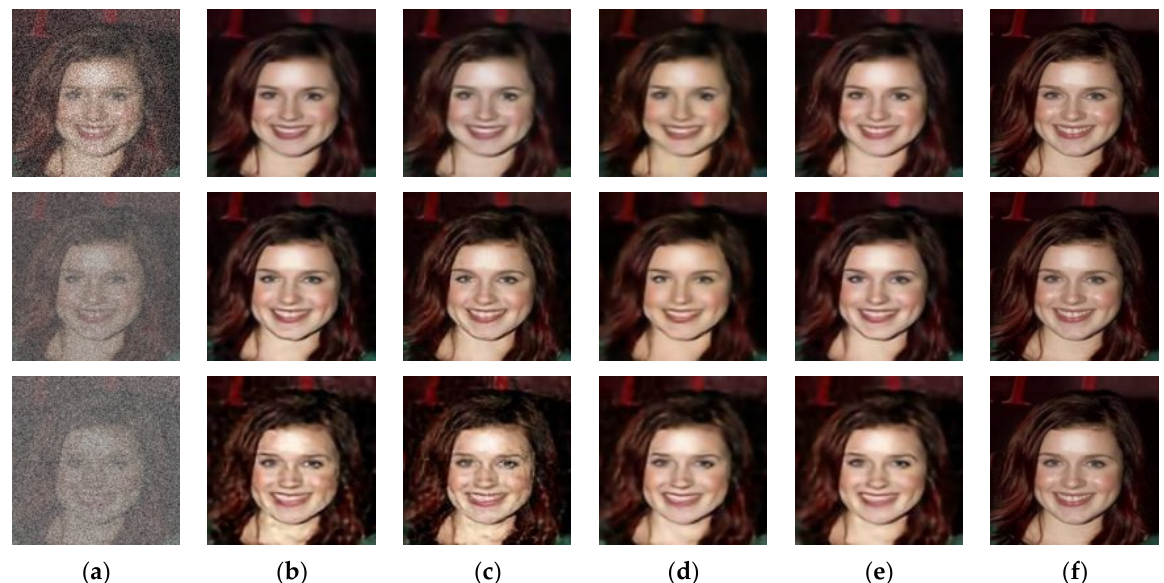
Figure 3. Results of different loss functions that construct different noise-free images from corresponding noisy images. The first row results are the noise level of sigma 25. The second row results are the noise level of sigma 50. The third row results are the noise level of sigma 100. ( a ) input noisy image, ( b ) result of L2 alone, ( c ) result of L2 and adversarial loss, ( d ) result of L1 alone, ( e ) result of the proposed AGDN loss function, and ( f ) target image.